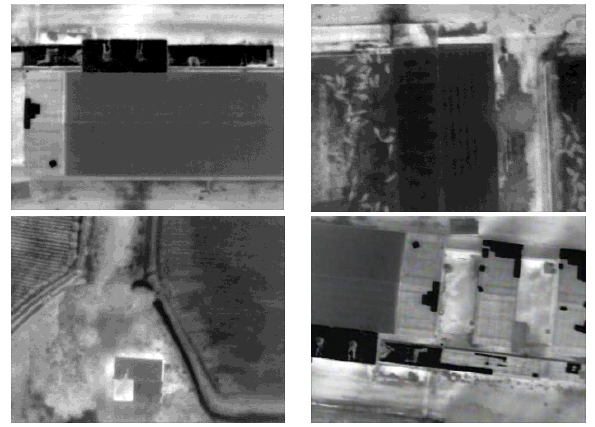
Figure 1. Frame extracted from thermal video